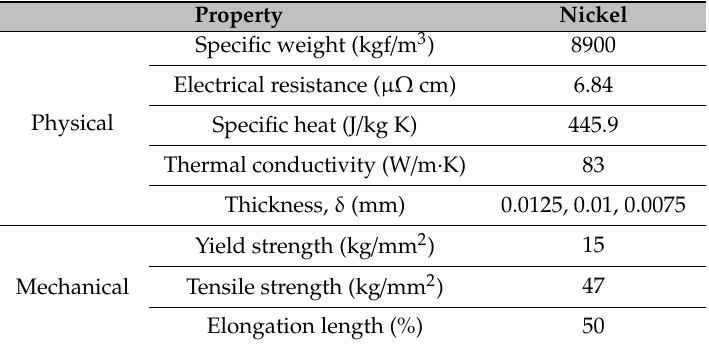
Table 2. Physical and mechanical properties of the tested metal sheets.